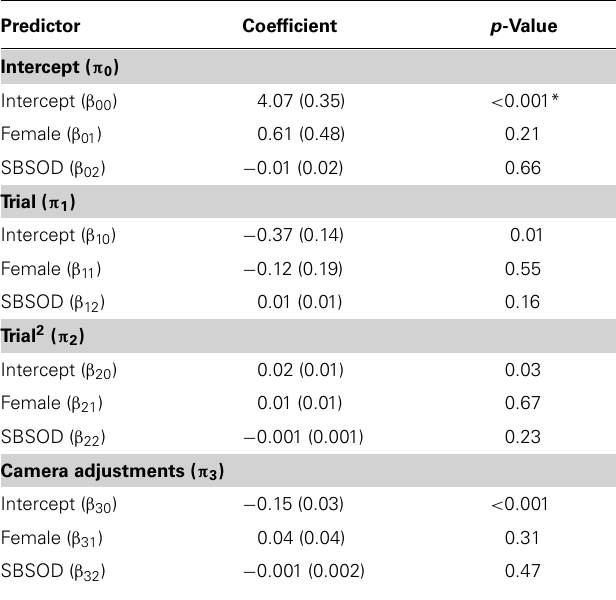
Table 3 | Regression coefficients for distance to the target location on south trials.